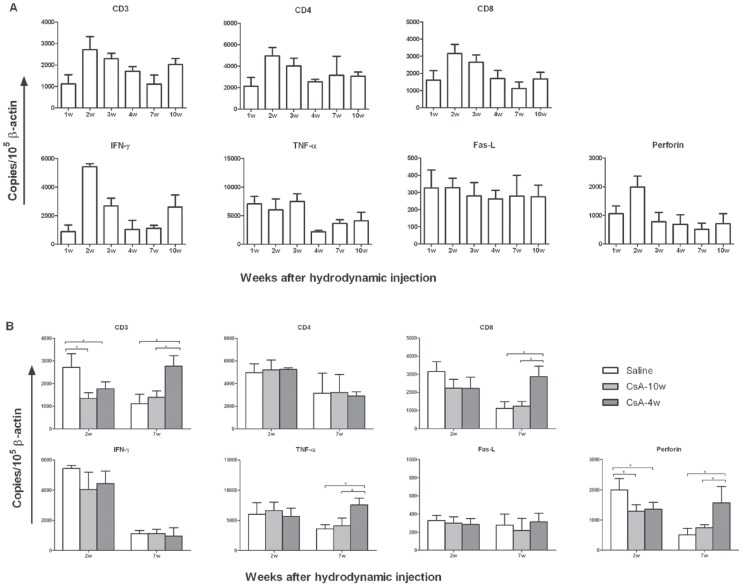
The influence of CsA treatment on the intrahepatic T cell response in mice after the HI.The mice were treated with saline or CsA from 1 week before the HI to 4 weeks (CsA-4w) or 10 weeks (CsA-10w) after the HI. The liver samples were collected from the mice (n≥3) at the indicated time points. The T cell markers, antiviral cytokines, and cytotoxic molecules were analyzed by real-time RT-PCR and are shown as the mean expression levels relative to 105 β-actin mRNA copies. (A) Dynamic changes in the intrahepatic expression of the T cell-related molecules in the saline-treated mice. (B) The expression of the T cell-related molecules was compared in livers from the saline- or CsA-treated mice at w2 and w7. * P<0.05.